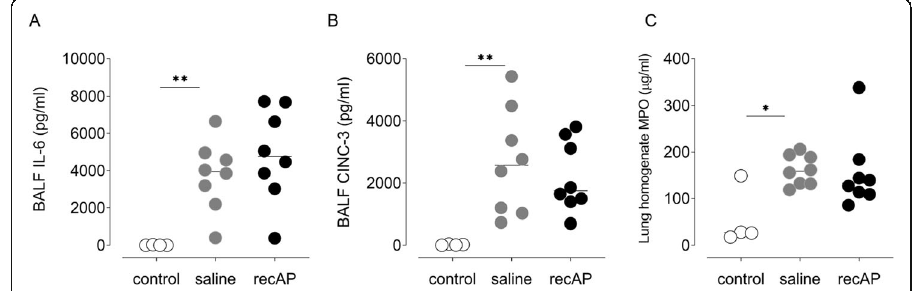
Fig. 5 Markers of pulmonary inflammation in the two-hit lung injury model in rats. a IL-6 levels in BALF. b CINC-3 levels in BALF. c MPO levels in lung homogenate. Abbreviations: BALF, bronchoalveolar lavage fluid; IL, interleukin; CINC, cytokine-induced neutrophil chemoattractant; MPO, myeloperoxidase; recAP,